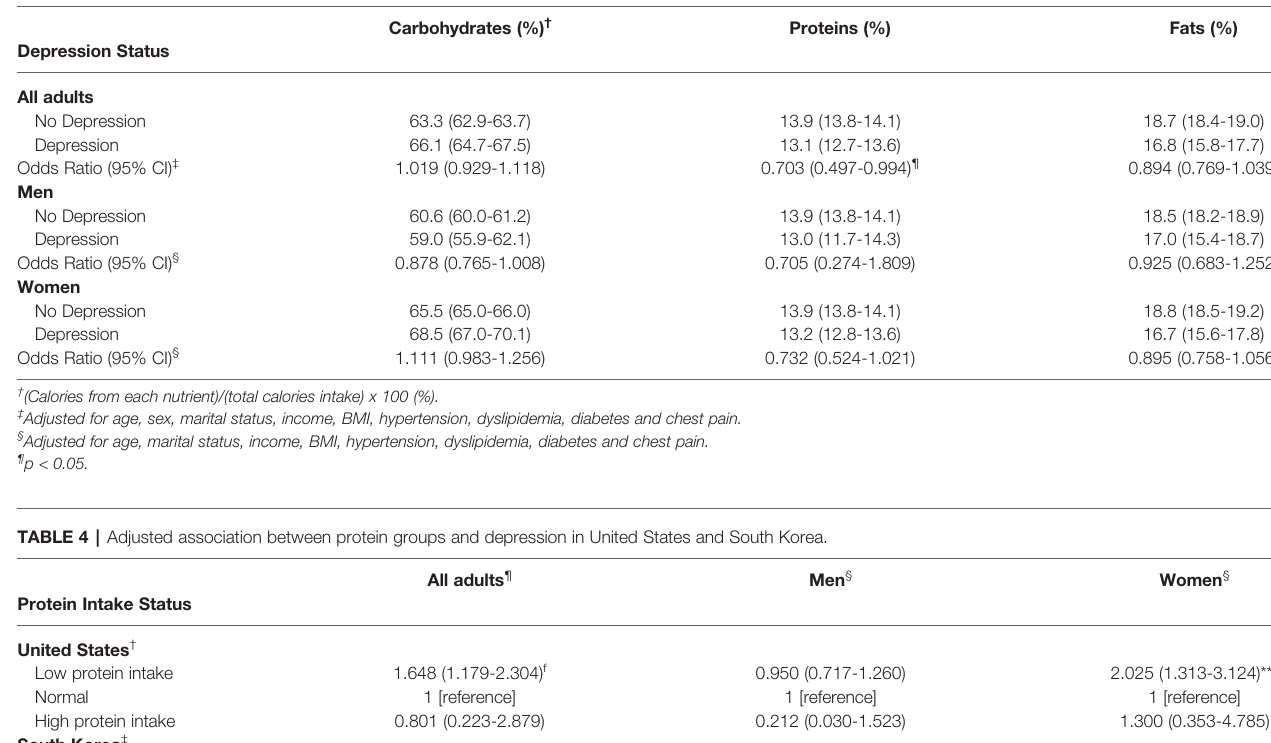
TABLE 3 | Adjusted association between calories from each nutrient and depression in South Korea, 2014 and